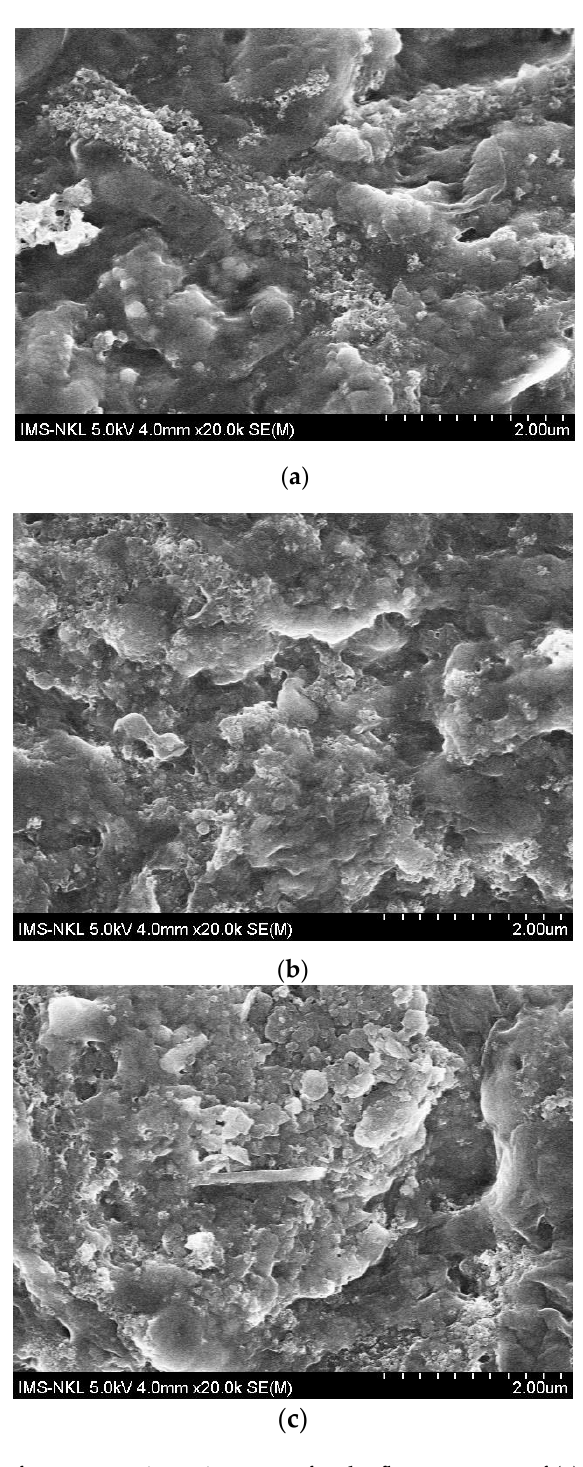
Figure 6. The images from a scanning microscope for the floc structures of ( a ) untreated, ( b ) ozone, and ( c ) ultrasound pretreated sludge samples.